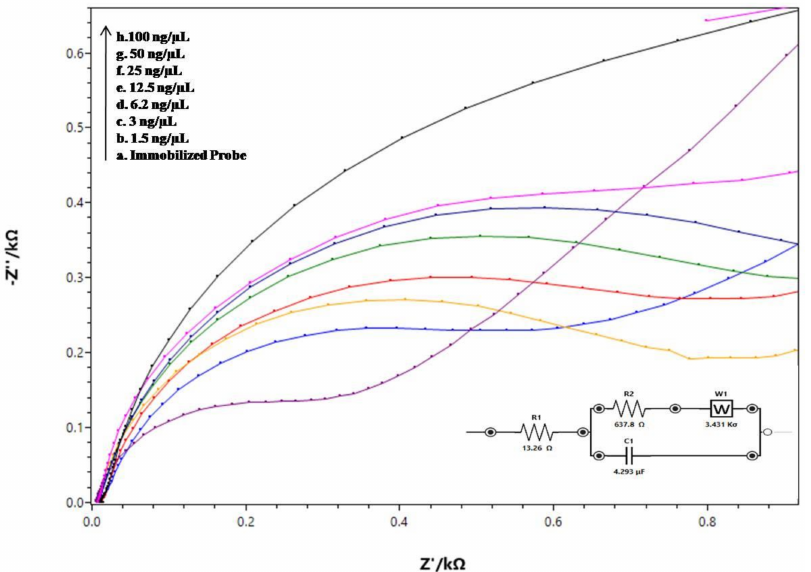
Figure 4. Comparison of the electrochemical impedance spectra of the DNA chip fabrication steps, including (a) the immobilization of the 5 (cid:48) amino-linked DNA probe and (b–h) hybridization with various concentrations of ssDNA of L. interrogans using 1-mM Potassium ferricyanide solution. The sensor response ( Ip value) was changed (increased) after the hybridization with ssGDNA and raised similarly with different concentrations of L. interrogans ss- GDNA (0.016–67.5 ng/ µ L). The plot of the Ip values vs. concentration of the ssGDNA